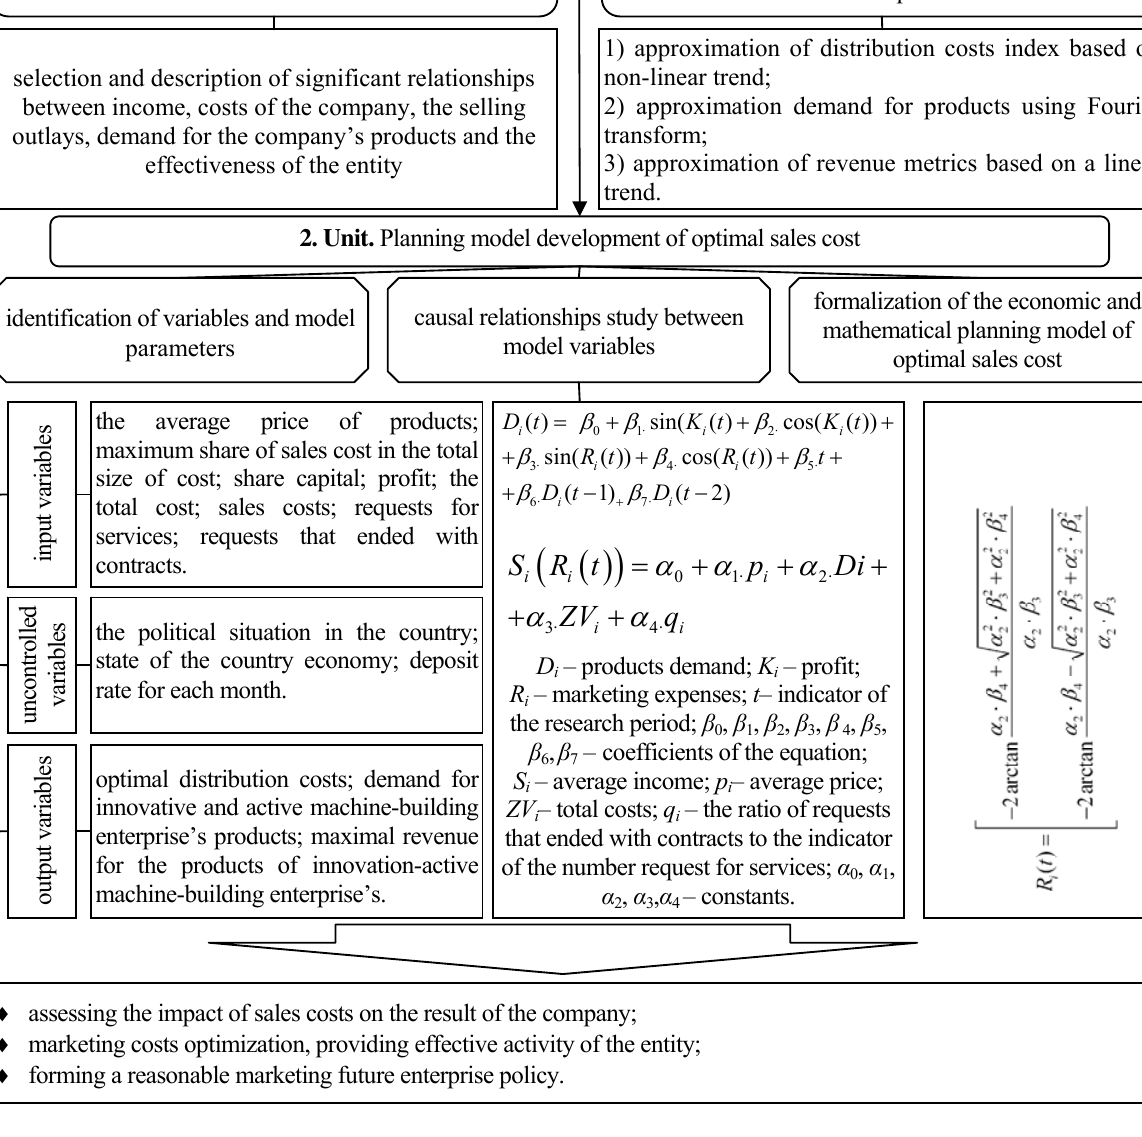
Fig. 1. Scientific and methodic approach to plan optimal marketing expenses value of the innovatively active machine building